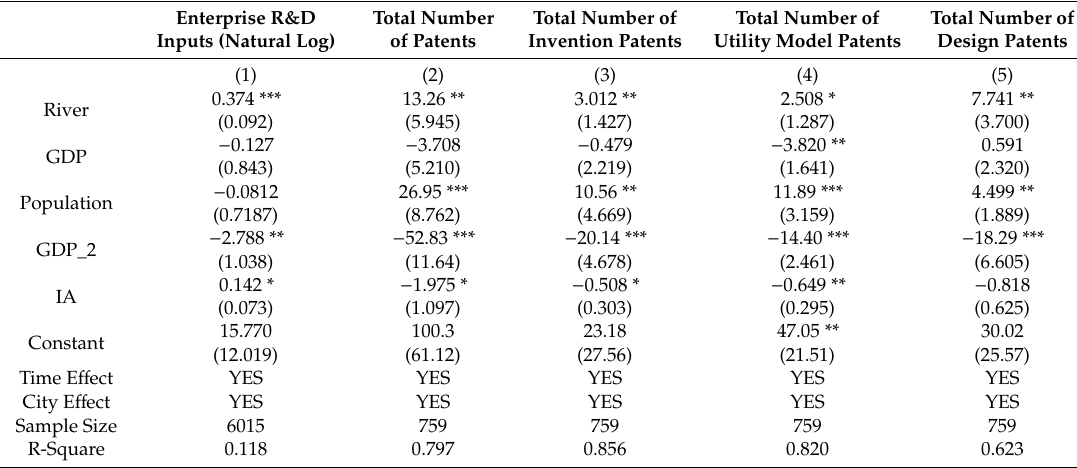
Table 5. E ff ects of the RCS on regional